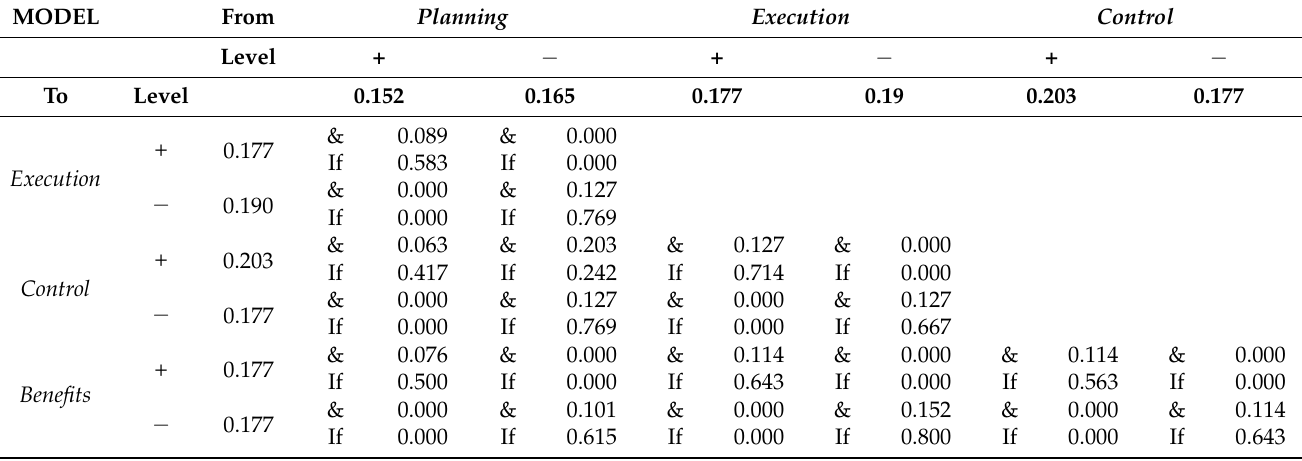
Table 9. Sensitivity